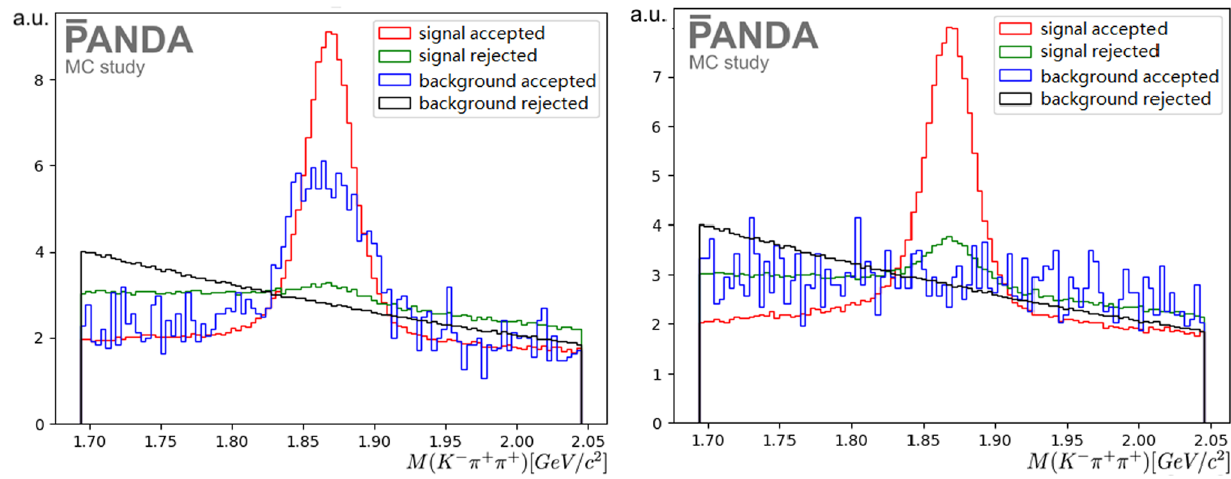
Fig. 8 Candidate mass distributions of accepted and rejected signal (red and green, respectively) and background (blue and black, respec- tively) for the channel Dch at 4.5 GeV/ c . Left, all kinematic input